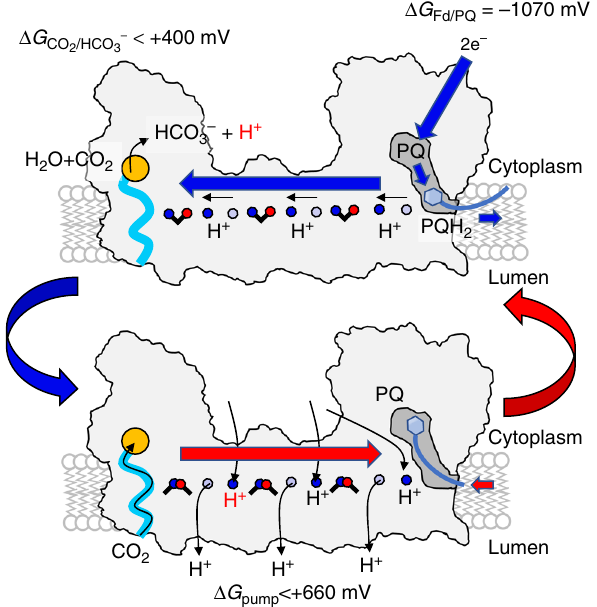
Fig. 4 Putative mechanism of redox-driven CO 2 concentration in the photosynthetic complex I. Top: PQ reduction to PQH 2 leads to dissociation of the quinol to a membrane-bound PQ-binding site 71 that triggers sequential opening of ion-pairs in NdhB, NdhD3, and NdhF3, by coupled hydration, conformational, and protonation changes, protonating terminal proton loading sites (blue forward arrow) 19, 20 . Bottom: Closing of ion-pairs in a sequential electrostatic backward pulse (red backward arrow) releases the protons to the luminal side of the membrane, and allows for re- protonation of the antiporter-like subunits by protons released from the CO 2 hydration reaction in the active site of CupA (orange circle). Horizontal proton transfer reactions within each antiporter-like subunit are shown by small horizontal black arrows, and PQH 2 (PQ) diffusion out (in) is indicated by small thick blue (red) arrows. CO 2 is taken up by the putative gas channel (in light blue) that is expected to be open depending on the ion-pair conformation in NdhF3 (arrow along light blue